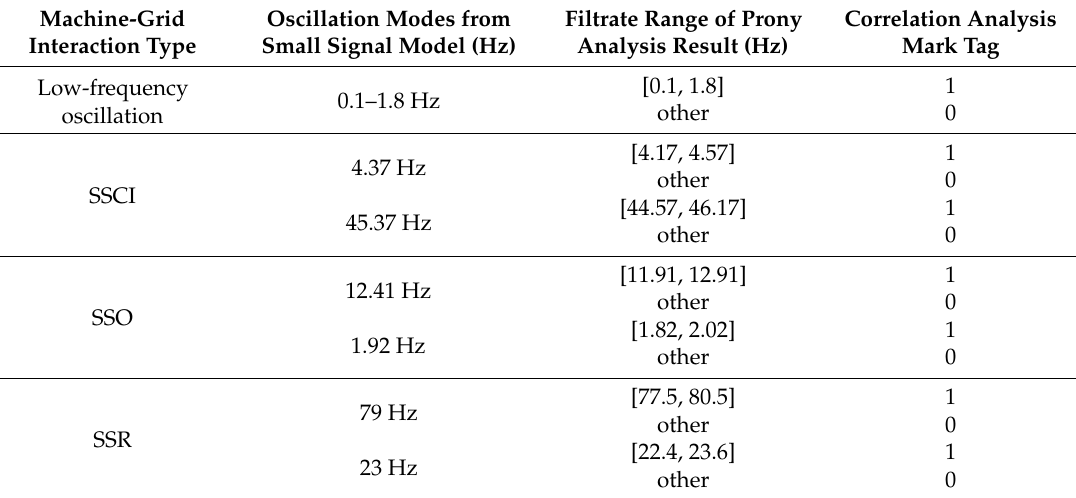
Table 3. Frequency filtrating